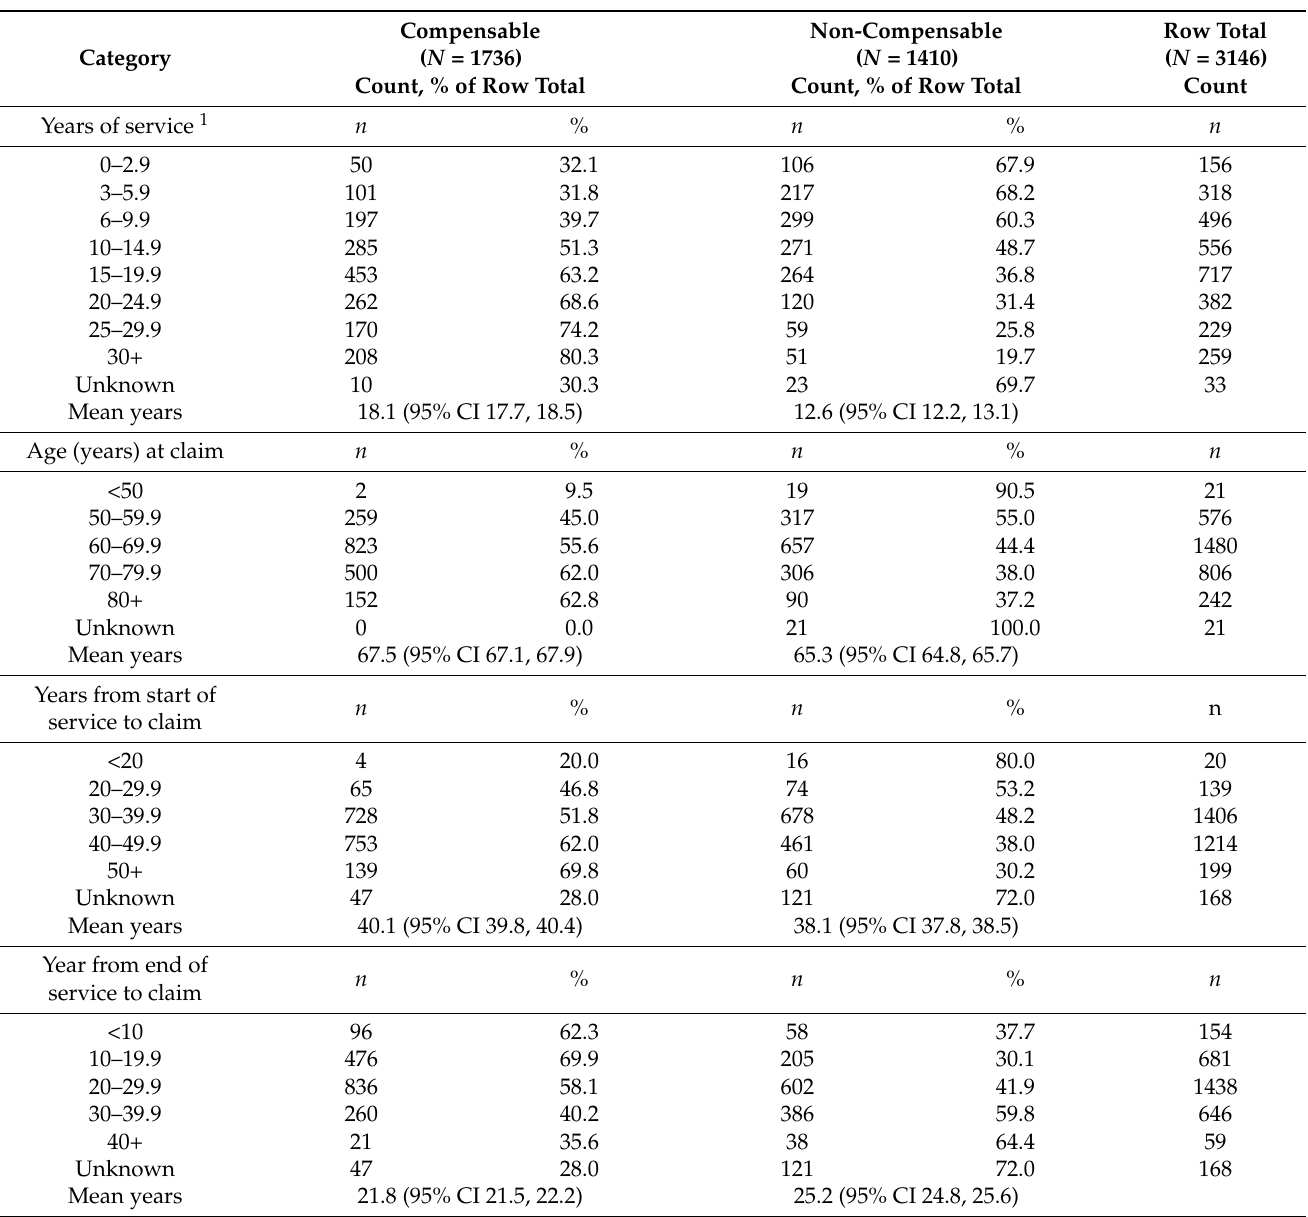
Table 1. Compensable and non-compensable silicosis claimants by length of service, age, and years since first and last exposure ( N =